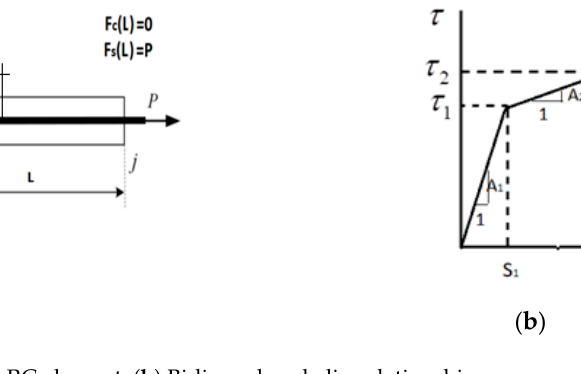
Figure 2. Problem definition. ( a ) RC element; ( b ) Bi-linear bond-slip relationship.